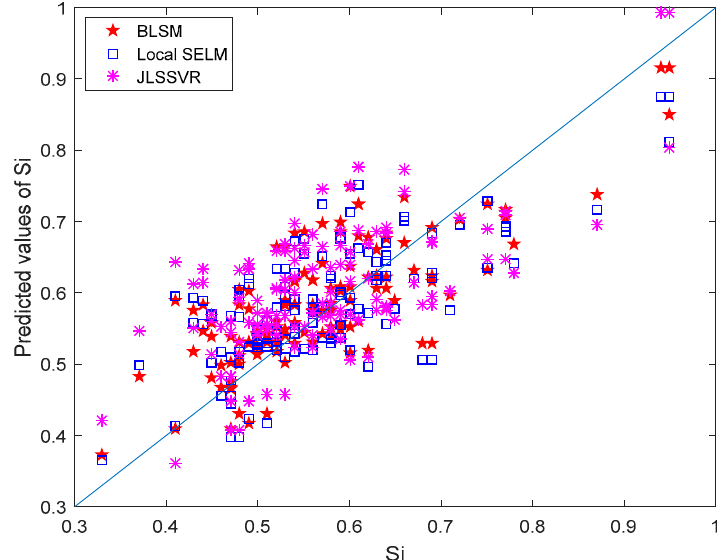
Figure 6. The silicon content assay values against prediction results using bagging local semi-supervised model (BLSM), semi-supervised extreme learning machine (SELM), and just-in-time least squares support vector regression (JLSSVR) soft sensors. Table 1 Detailed prediction performance comparison of semi-supervised and supervised learning models (best results are bold and underlined).